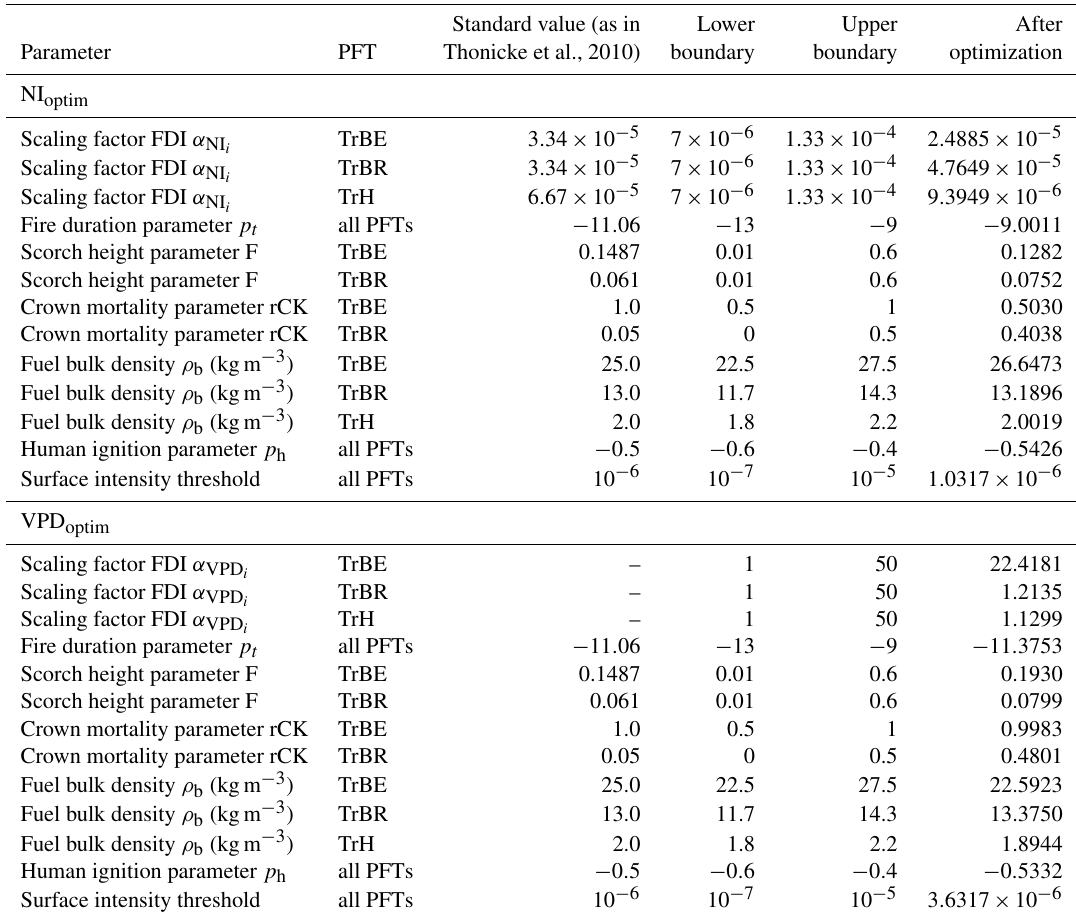
Table 2. All optimized parameters with their standard values, the upper and lower boundary of the parameter ranges, and the resulting optimized value including parameters for specific PFTs and global parameter, which have the same value for all PFTs. All parameters except ρ b have no